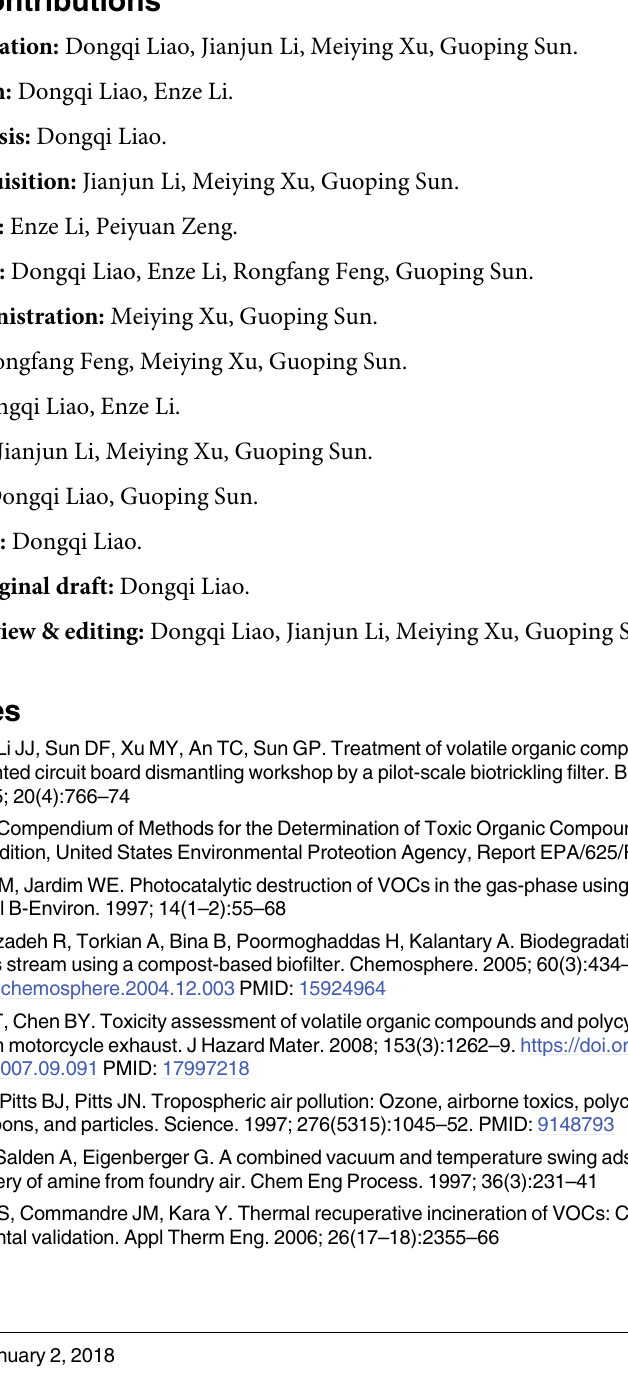
S1 Table. Elimination capacities of toluene, styrene and xylene at 90% removal